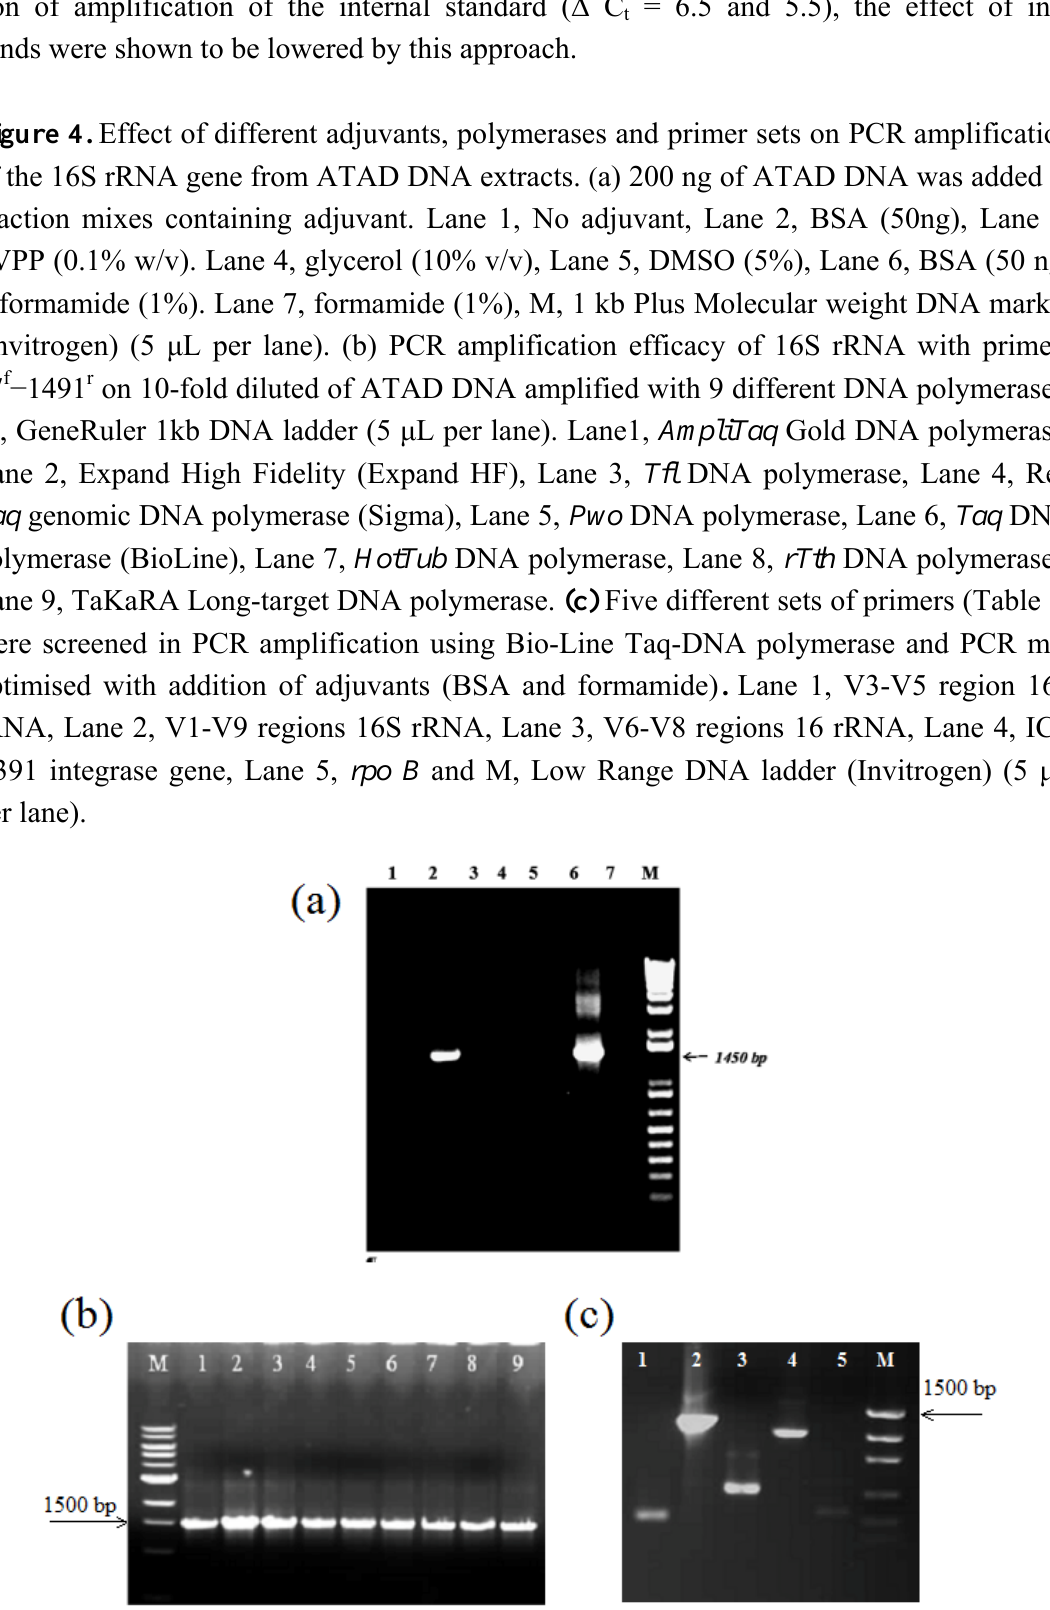
Figure 4. Effect of different adjuvants, polymerases and primer sets on PCR amplification of the 16S rRNA gene from ATAD DNA extracts. ( a) 200 ng of ATAD DNA was added to reaction mixes containing adjuvant. Lane 1, No adjuvant, Lane 2, BSA (50ng), Lane 3, PVPP (0.1% w/v). Lane 4, glycerol (10% v/v), Lane 5, DMSO (5%), Lane 6, BSA (50